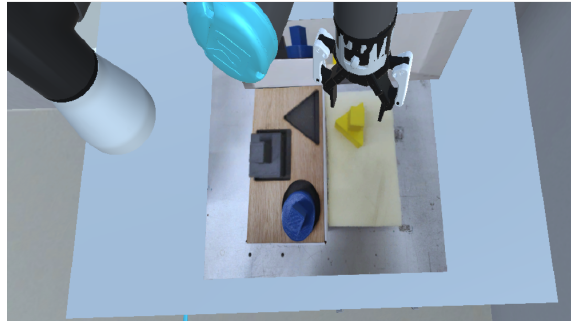
Figure 6. View of Augmented Virtuality setup.